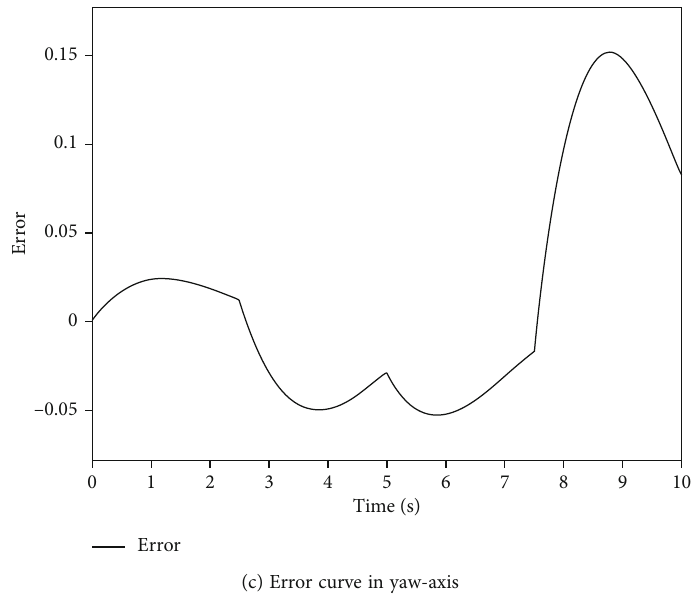
(c) Error curve in yaw-axis Figure 11: Error tracking of the fi rst motion